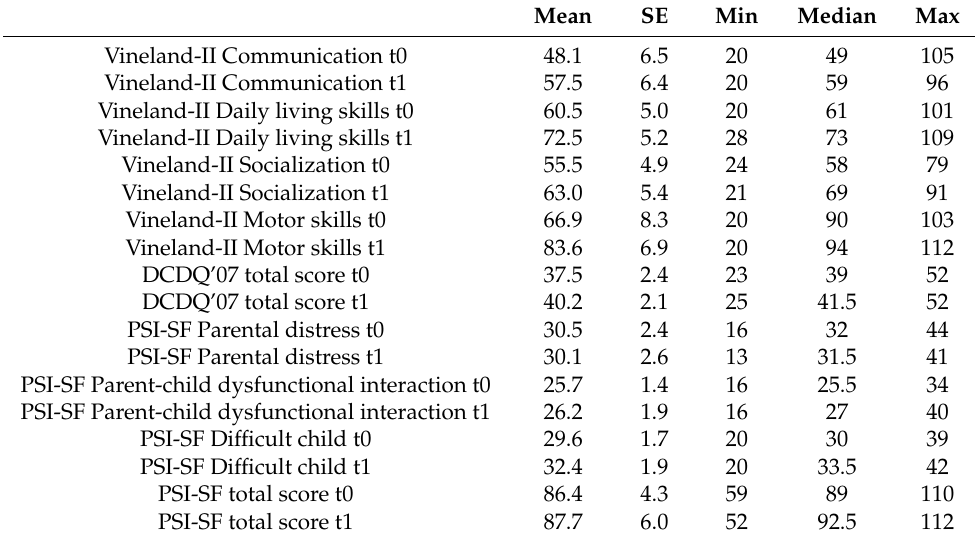
Table 1. Descriptive statistics of all of the measurements performed both before (t0) and after the 20 individual sessions (t1).